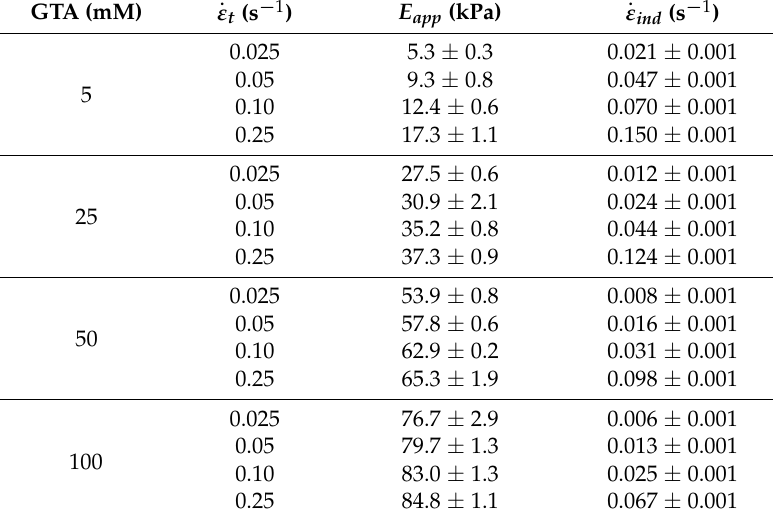
Table 1. Actual indentation strain rates ( GTA-crosslinked samples tested at different theoretical strain rates ( mean ± standard